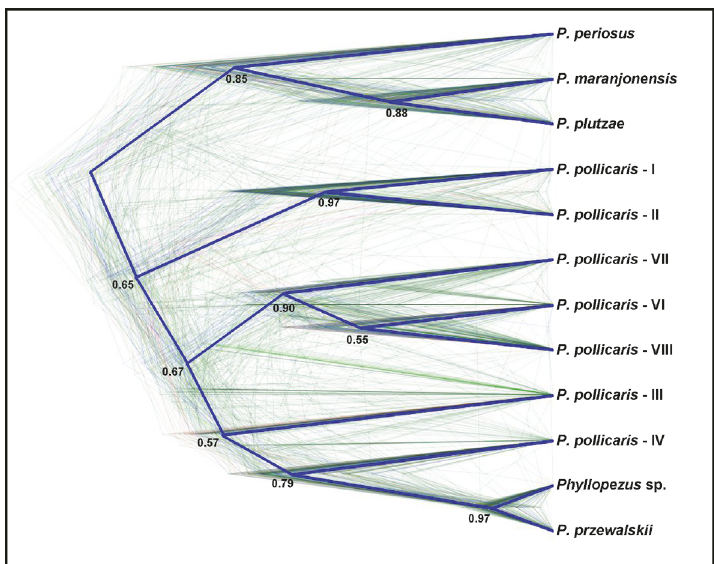
Figure3:Speciestreeinferredwith ∗ BEASTshowingdensityoftreesproportionaltofrequencyofoccurrence(thinlines)drawninDensiTree and the consensus tree (blue lines) with the posterior probability for each